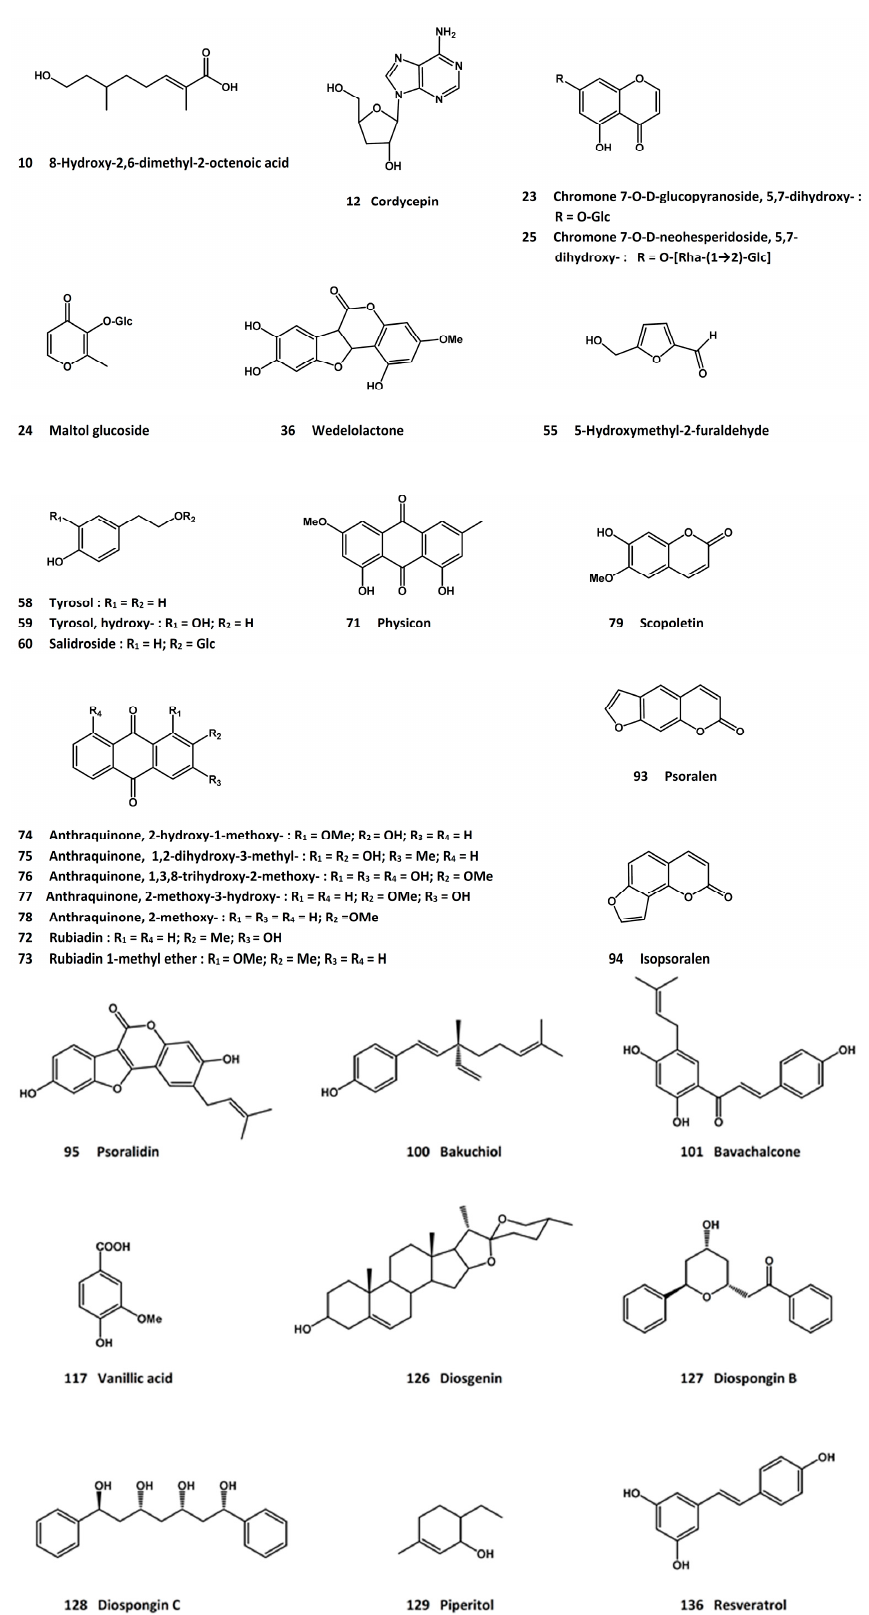
Figure 4. Miscellaneous compound types reported to possess osteoprotective property.